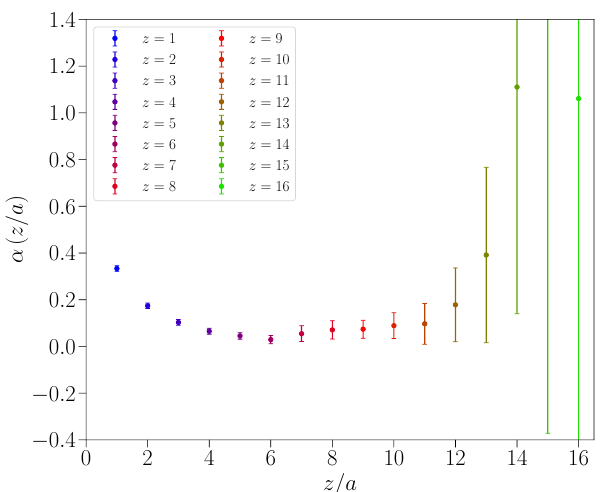
Figure 23. The fitted values of α from the cosine-transform of the two-parameter PDF func- tional form (5.1) fit to each z 2 of the matched ITD. The latter was obtained using (5.3) for the evolution/matching step. The values of α are statistically constant for 4 . z/a . 11 , with sharp deviations for small- z/a